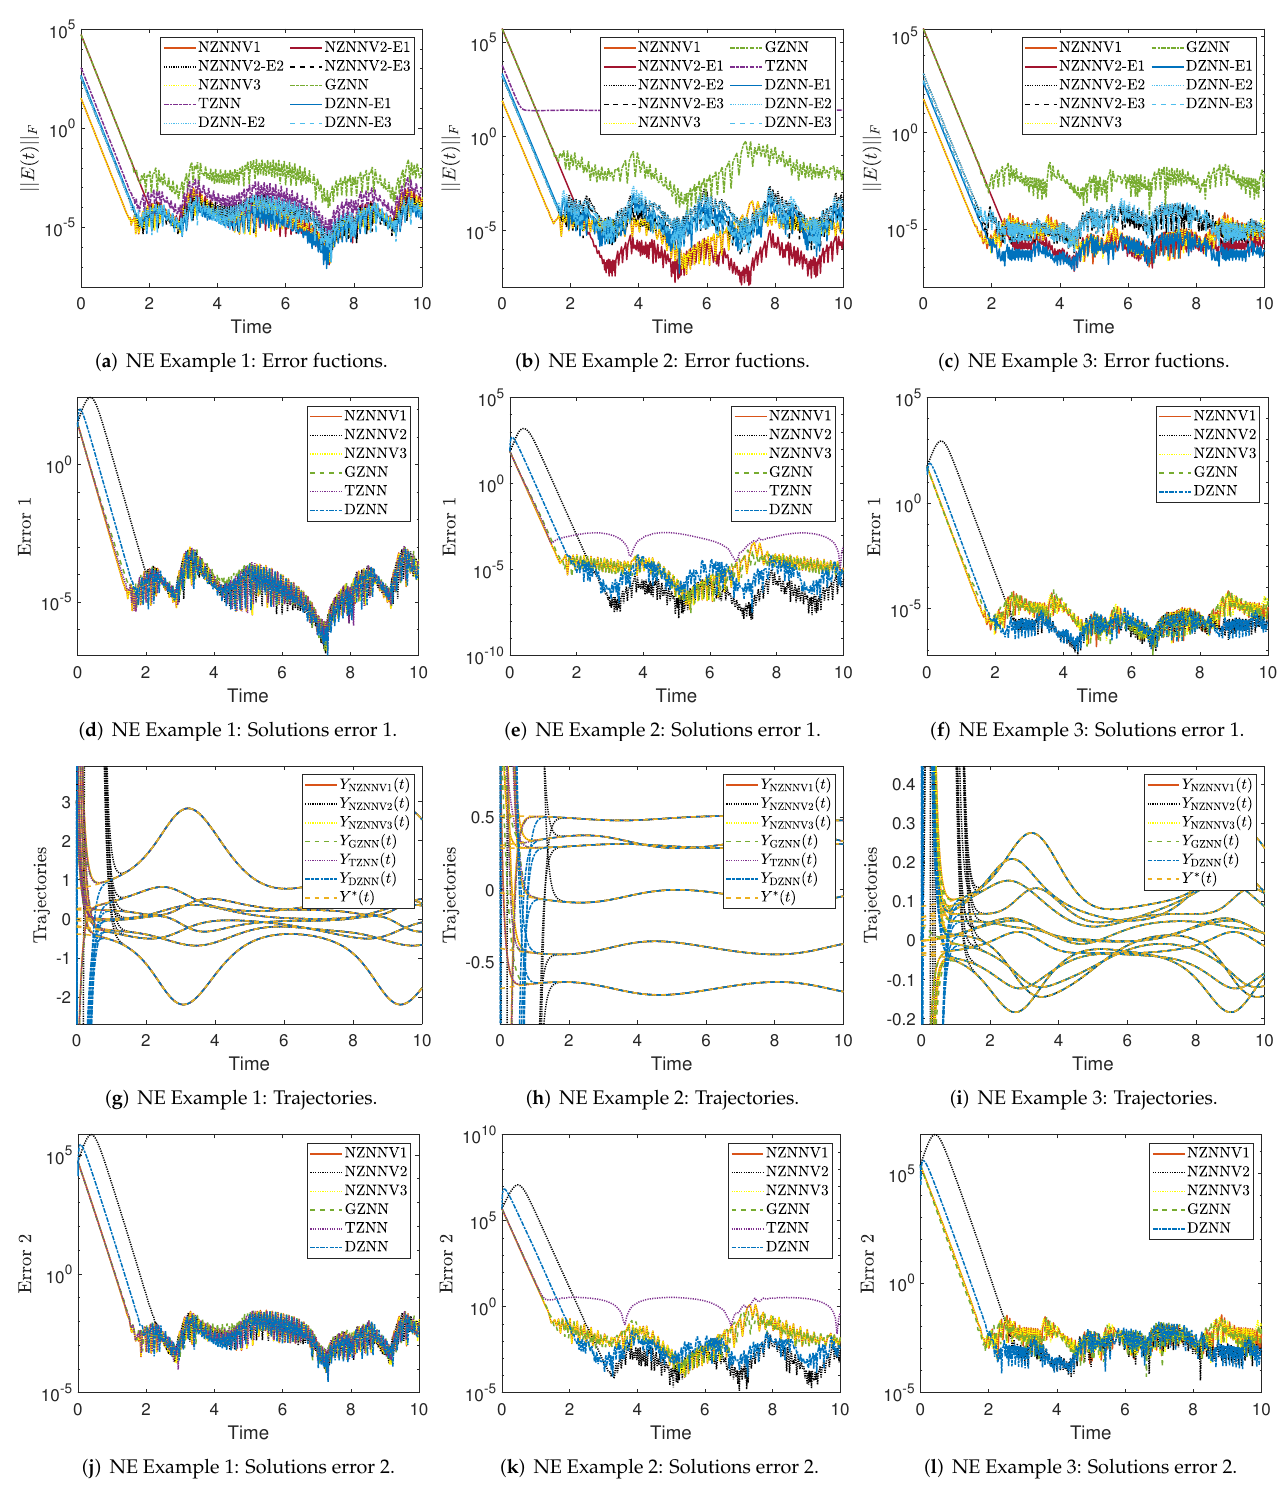
Figure 2. Errors and trajectories in NE Example 1, Example 2 and Example 3.